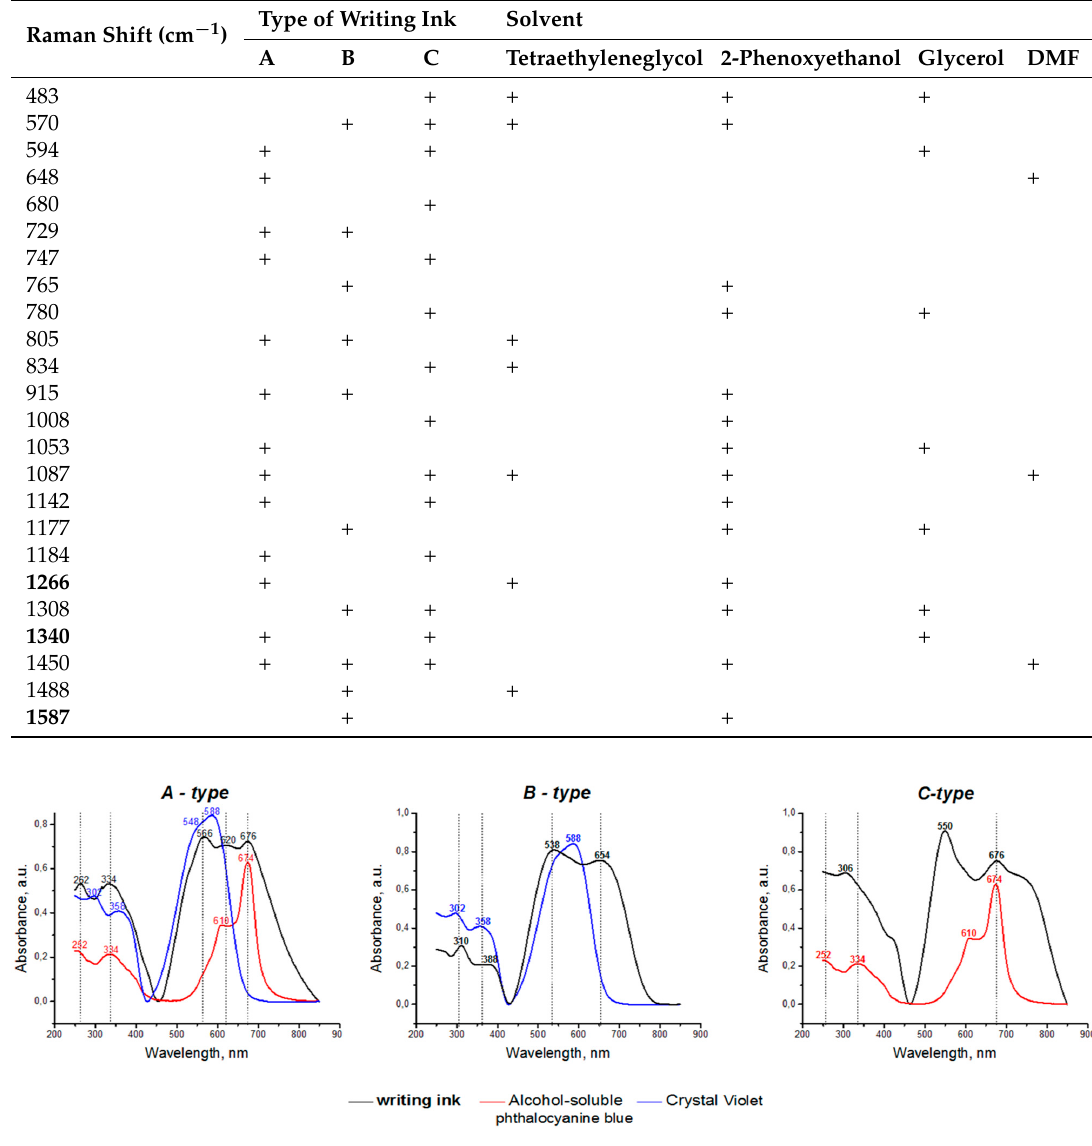
Figure 7. Electronic absorption spectra of writing inks of the A-, B- and C-types. Table 6. The characteristics of the writing inks chosen for the current work.